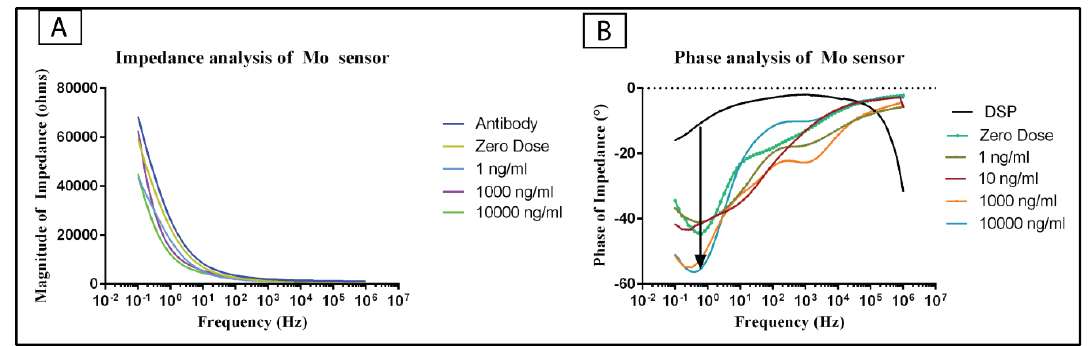
Figure 4. Magnitude and Phase analysis of Mo sensor. ( A ) Magnitude of impedance of Mo sensor. The magnitude of the impedance decreases with increasing antigen concentrations; ( B ) Phase analysis of Mo sensor. Maximum phase changes between the DSP functionalization step and subsequent assay steps were observed at 1 Hz